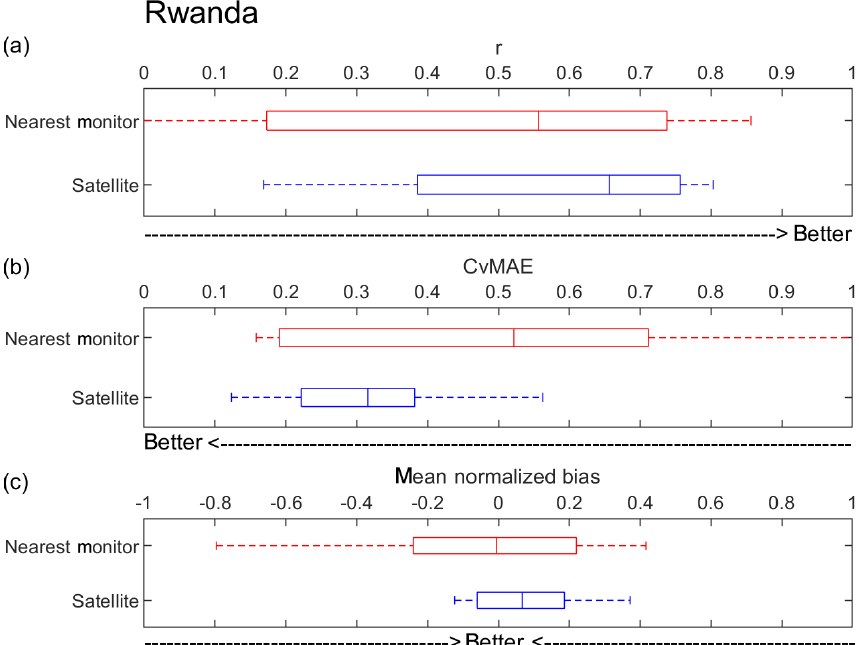
Figure 6. Comparison of performance metrics ( a correlation, b CvMAE, c MNB) for surface PM 2 . 5 estimated either from satellite AOD data (satellite) or from the nearest ground-level PM 2 . 5 monitor (nearest monitor) in the Rwanda area.